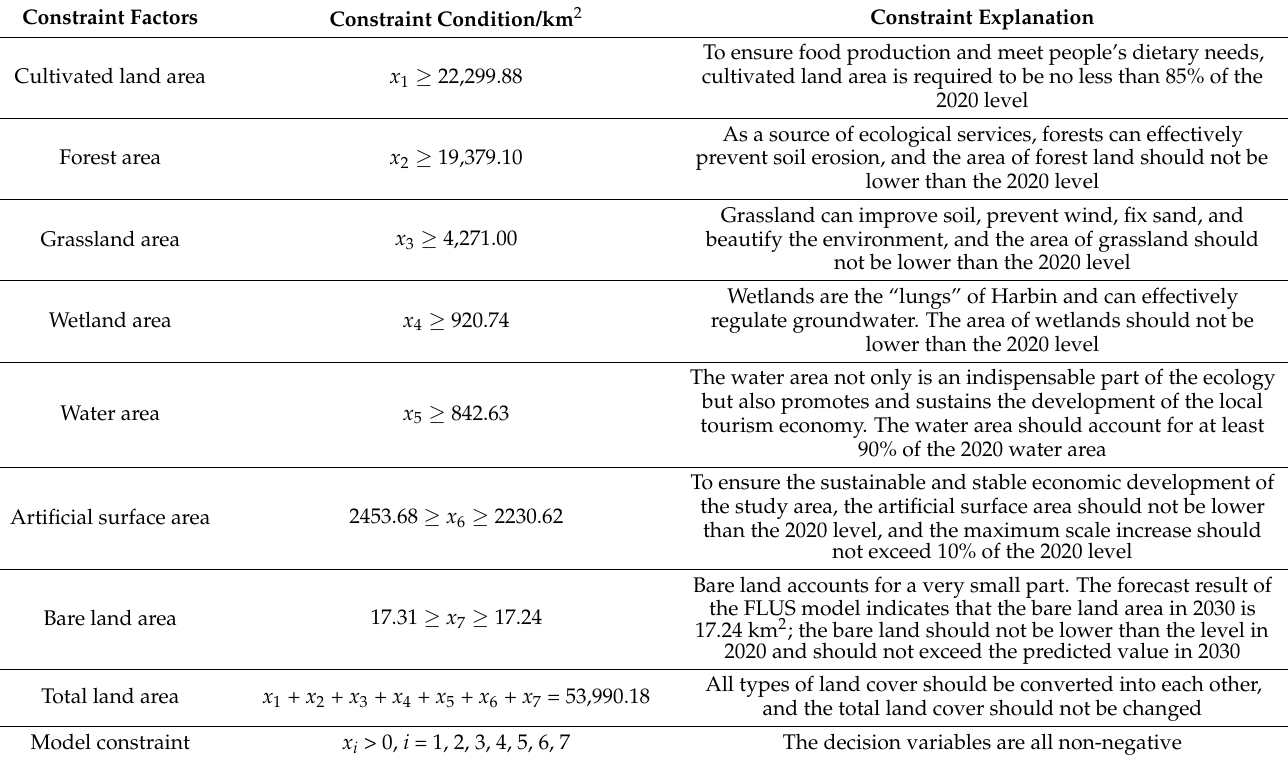
Table 3. Constraint conditions of the objective function of the multi-objective programming